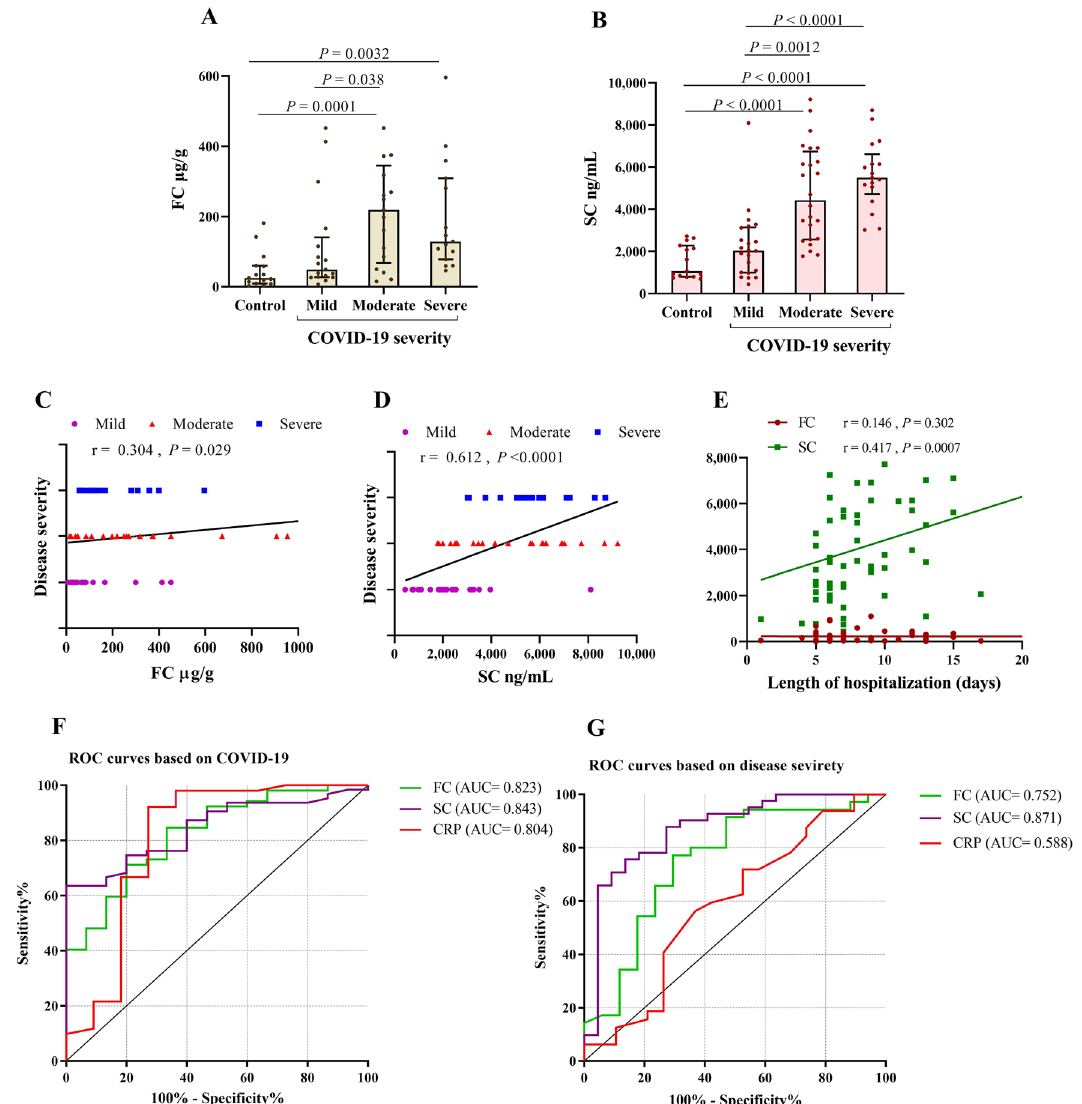
Figure 5. FC and SC relation to COVID-19 severity. Comparison of SC and FC levels according to three classes of disease severity ( A , B ). The correlation of FC or SC with disease severity ( C , D ). The correlation of FC or SC with the duration of hospitalization ( E ). Receiver operating characteristic (ROC) curve evaluation of the performance of FC, SC and CRP risk score in diagnosis COVID-19 patients or distinguish severe cases ( F , G ). AUC: under the ROC curve. P values are shown in the